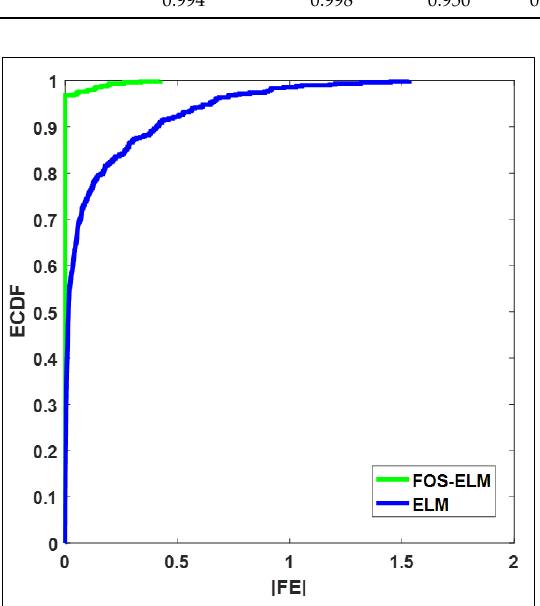
Figure 8. Empirical cumulative distribution function (ECDF) of the prediction error, |PE| for all input combination M 7 using the variable forgetting factor (FOS-ELM) vs. the extreme learning machine (ELM) model.